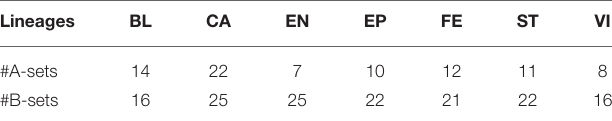
TABLE 1 | The number of hub TFs for all cell